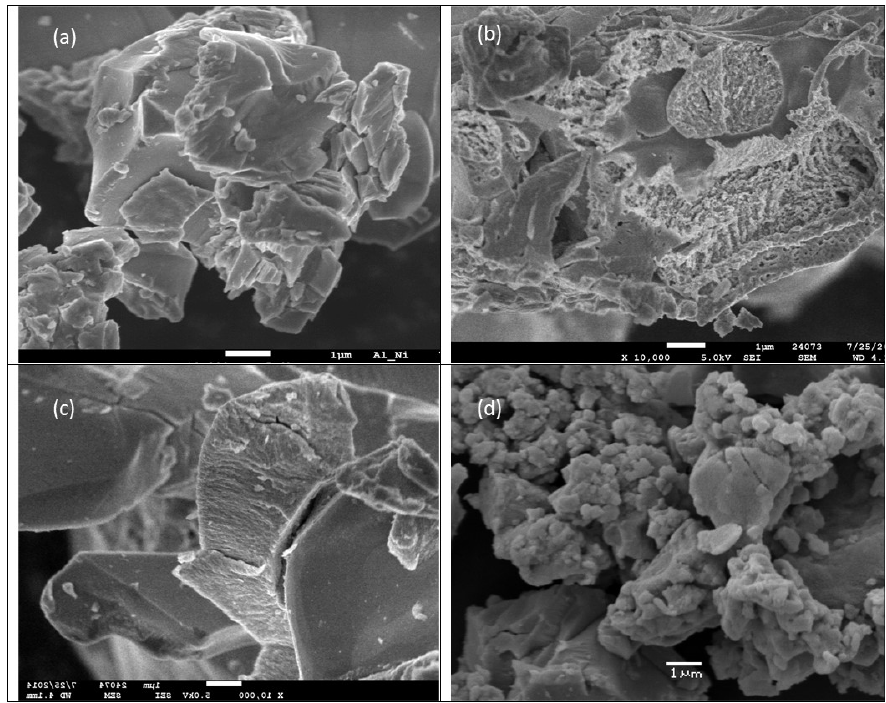
Figure 2. The SEM photos show the morphology of ( a ) starting commercial Raney Al-Ni alloy; ( b ) eroded Al-Ni alloy after HDC process (run No. 7 in Table 2); ( c ) used Al-Ni alloy in co-action of glucose, run No. 8 in Table 2; ( d ) cubic Ni particles obtained by action of NaOH/NaBH 4 (run No.15 in Table 2).